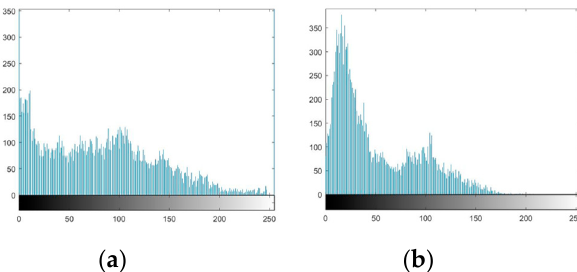
Figure 18. Gray-level histogram. ( a ) Taillight histogram in the lit state; ( b ) Taillight histogram in unlit state.